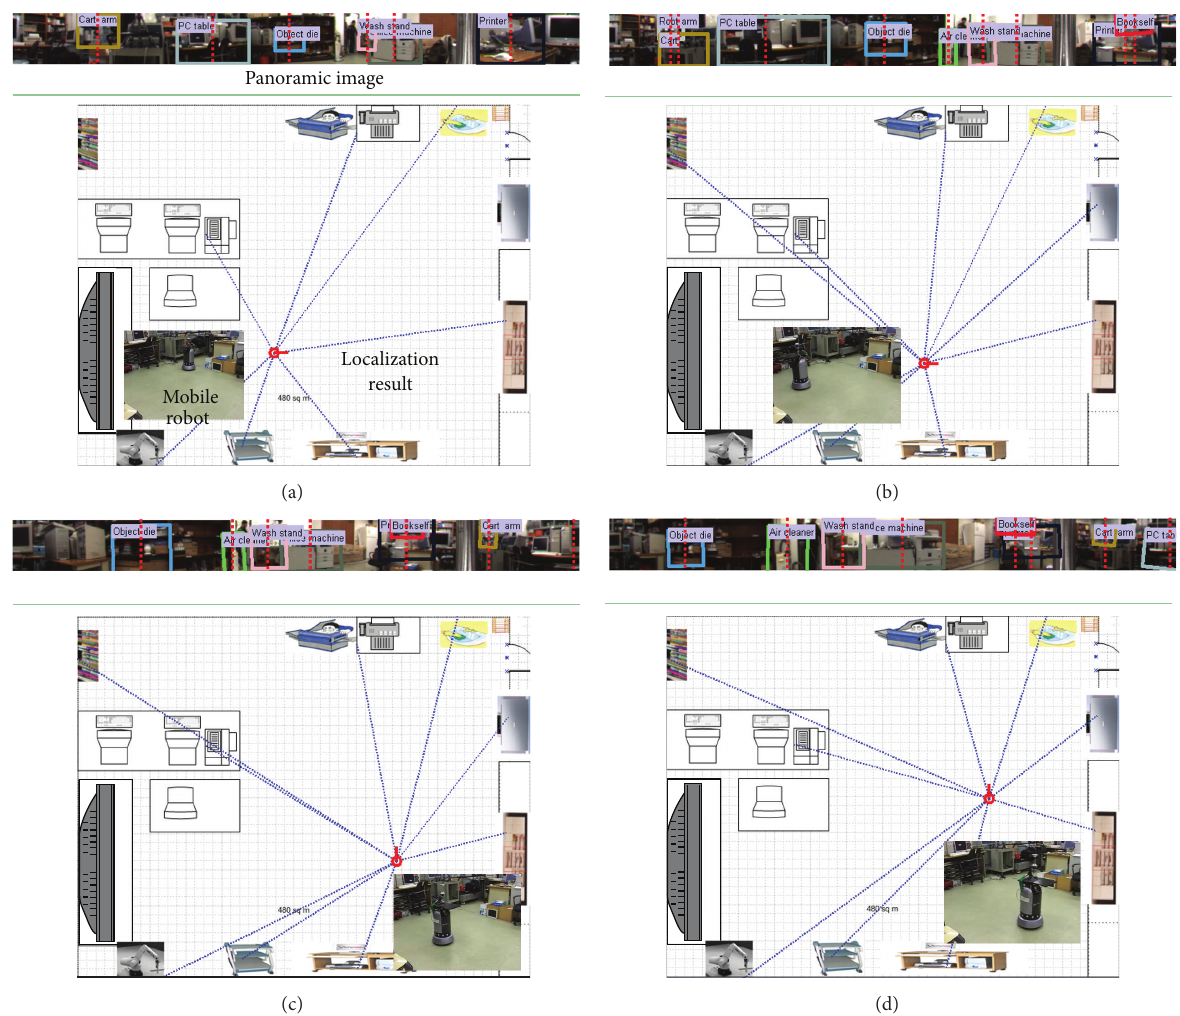
Figure 14: Examples of robot localization using the proposed method: (a) Frame #1, (b) Frame #20, (c) Frame #40, and (d) Frame